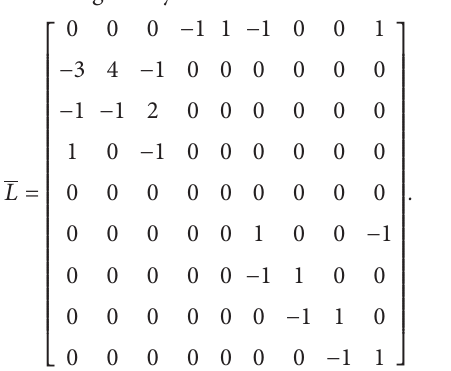
Figure 3: Dynamic multiconsensus: positions of agents.